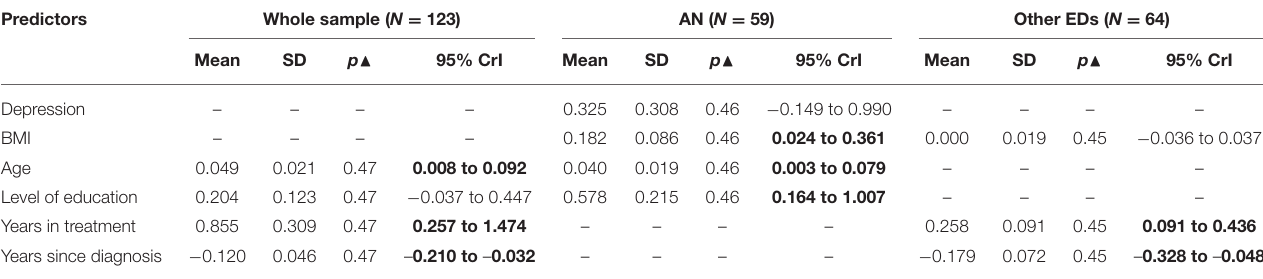
TABLE 5 | Predictors of smoking among the samples indicated by posterior probabilities from Bayesian modeling.